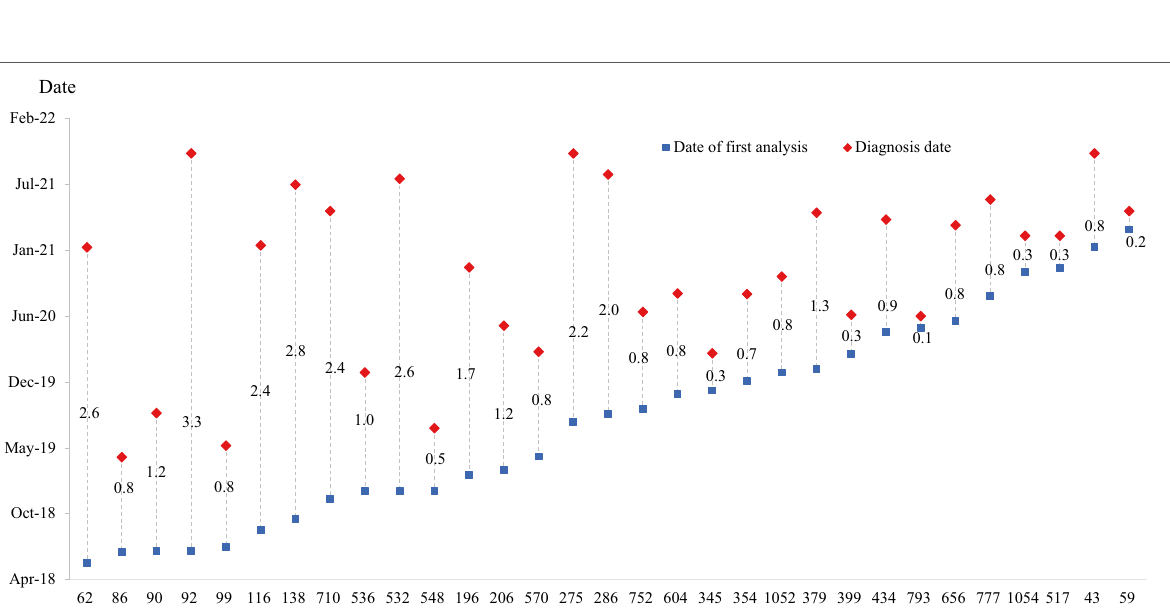
Fig. 5 The time interval between the first analysis (blue dot) and the molecular diagnosis (red dot) of patients diagnosed by reanalysis. Number: Time interval converted to